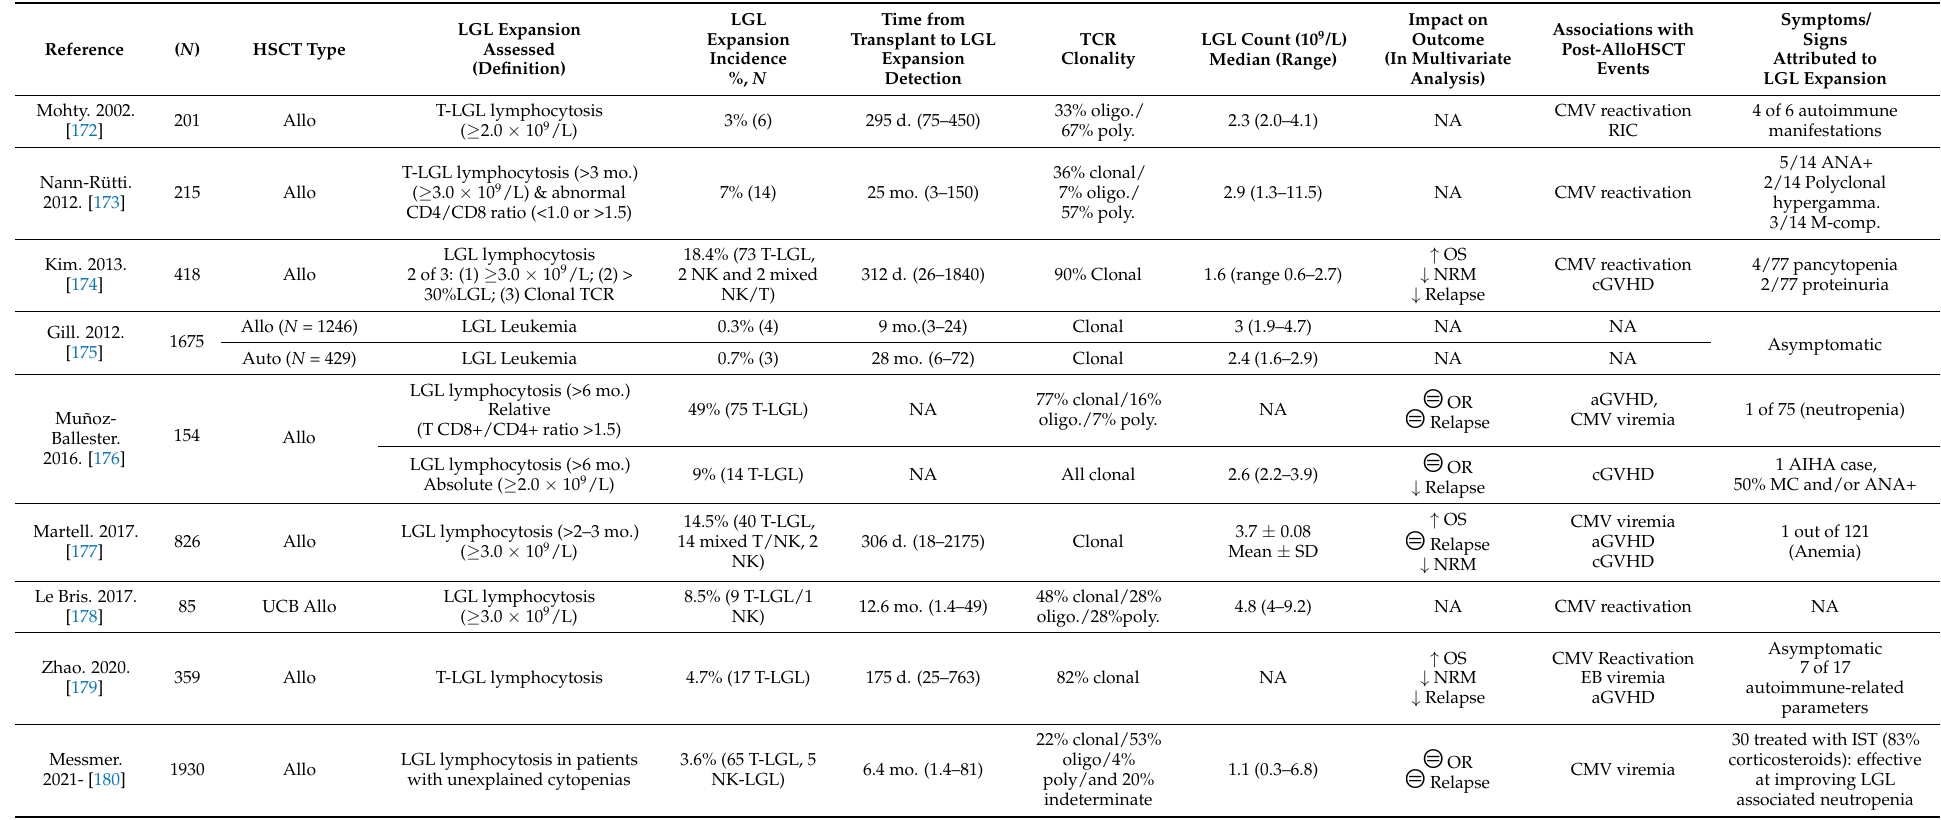
Table 4. LGLL and LGL expansions in HSCT